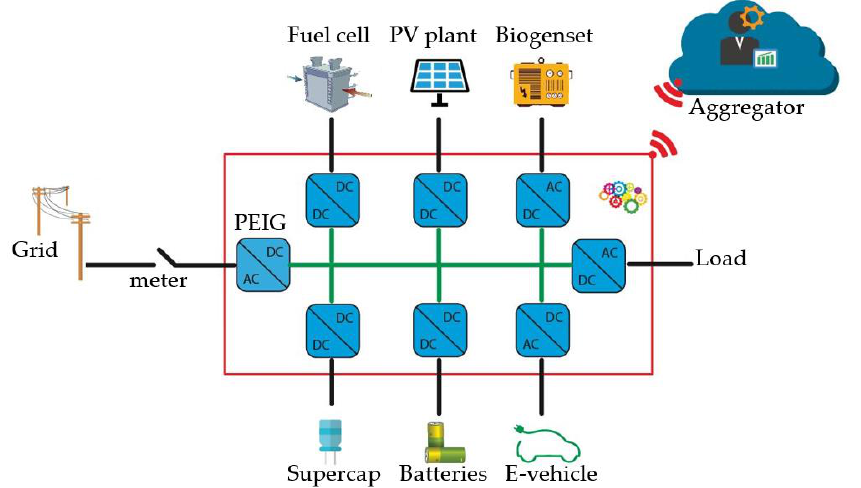
Figure 1. A grid-connected nanogrid for home application.